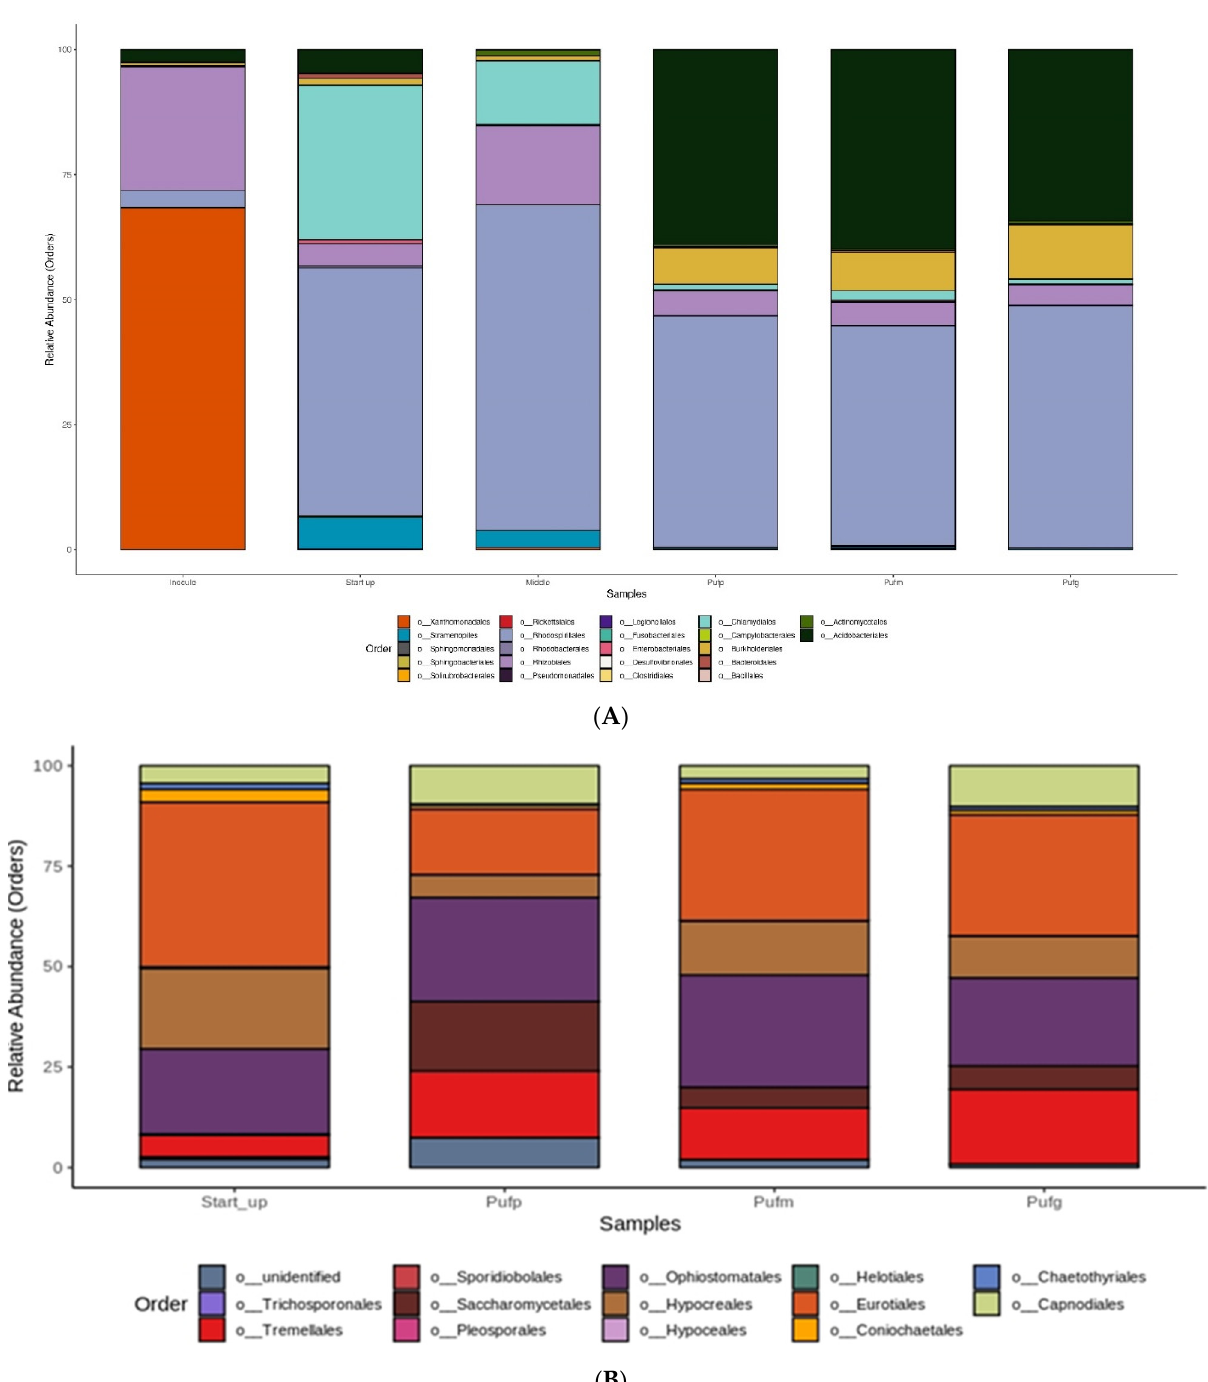
Figure 4. Relative abundance of different bacteria ( A ) and fungi ( B ) orders in the bioreactor. Out of all reads performed, in Figure 4 are shown those OTUs with more than 1% relative abundance and found in at least two thirds of replicates. Orders representing less than 1% of the total reads are grouped in ‘NA’. “Inocculum” t = 0; “start-up”: at the end of start-up phase t = 55 days; the “middle” t = 79 days; the “Pufp”: small PUFs, “Pufm”: medium PUFs and “Pufg”: big PUFs in the end of the treatment t = 121 days.